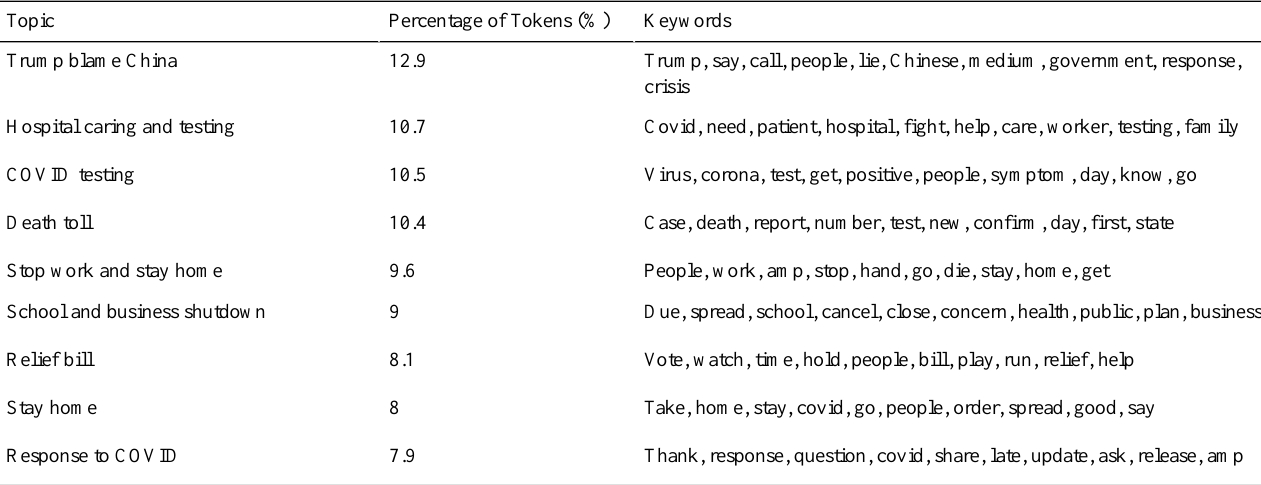
Table 2. Major topics discussed in COVID-19 tweets posted by e-cigarette nonusers (non-Ecig group) in the US, from March 5, 2020, to April 3, 2020. KeywordsPercentage of Tokens